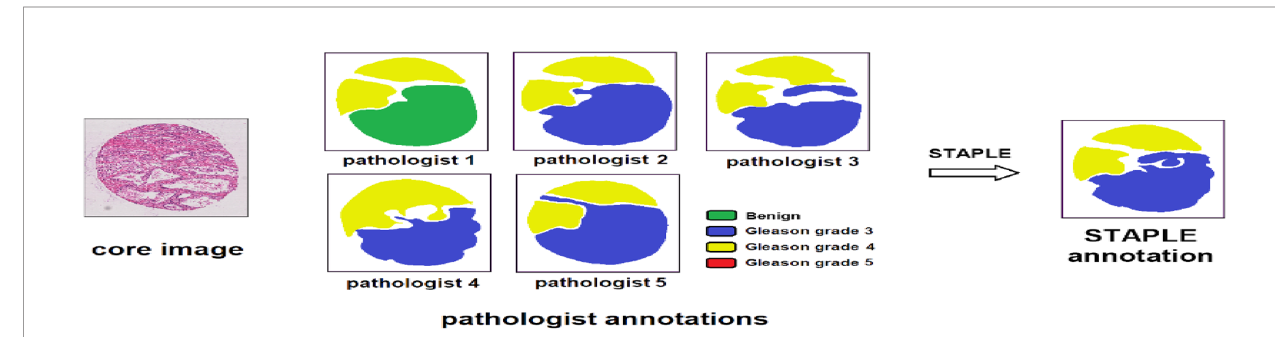
FIGURE 1 | Image processing of pathologist annotations of TMA core images. The STAPLE algorithm, the same as pixel-wise majority voting, fuses the annotations of different pathologists to build the “ ground truth label ”